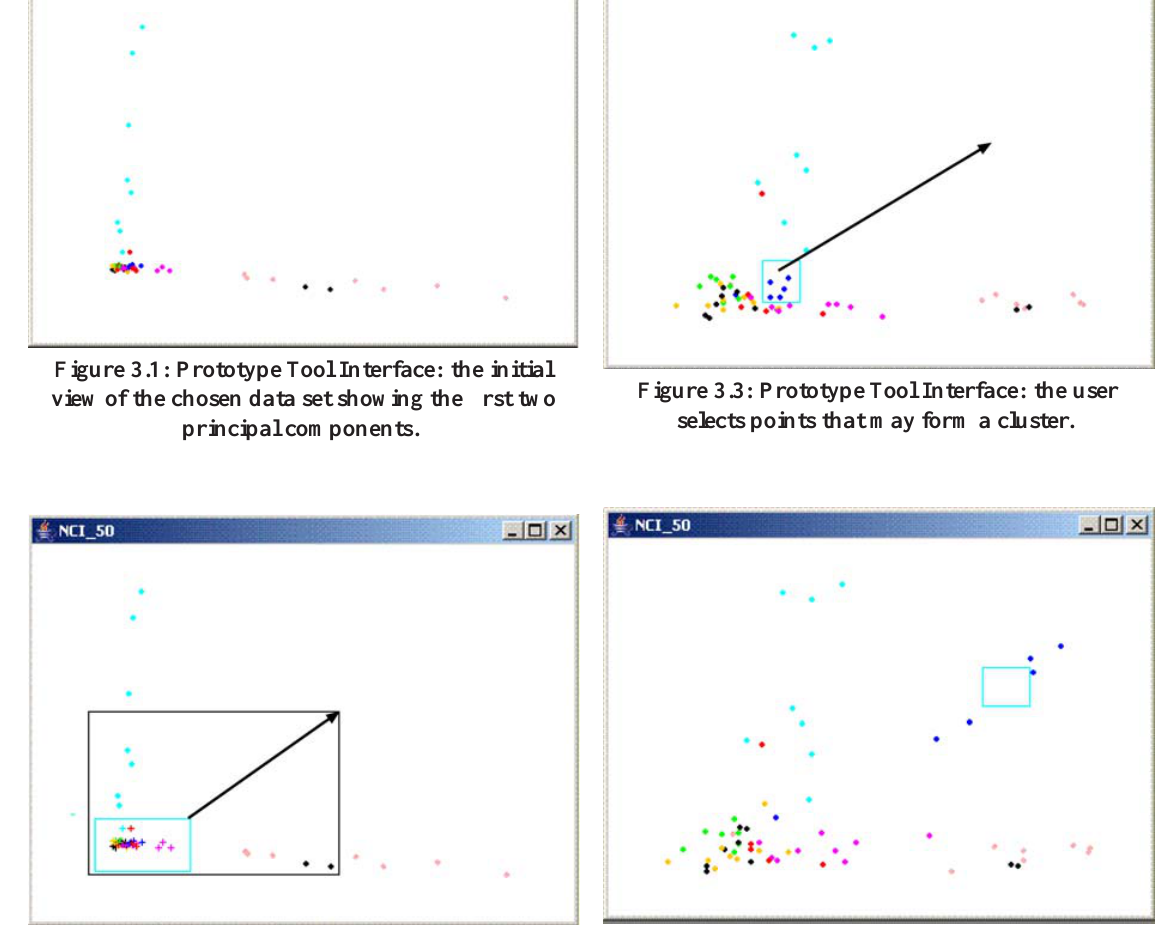
Figure 3.2: Prototype Tool Interface: the user expands a region to distinguish bunched points.